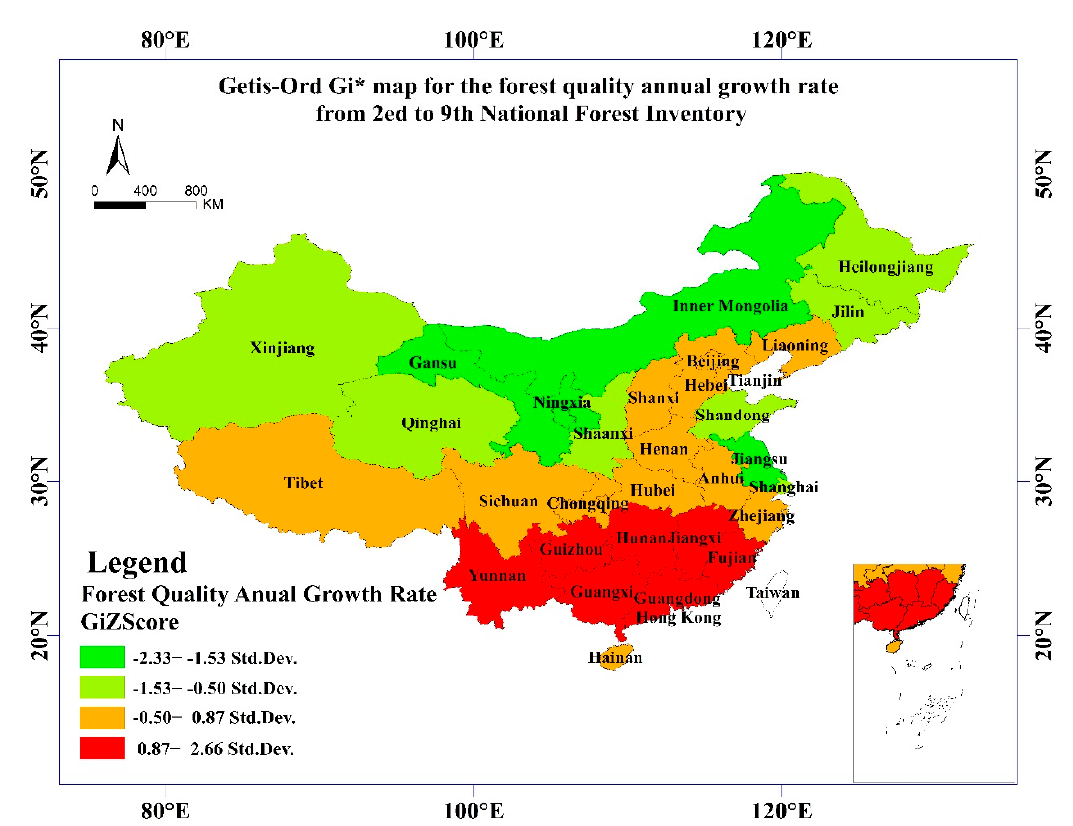
Figure 3. Getis-Ord Gi* values and its statistical test for the forest quality from the 2nd to 9th national forest inventory (1984–2018).